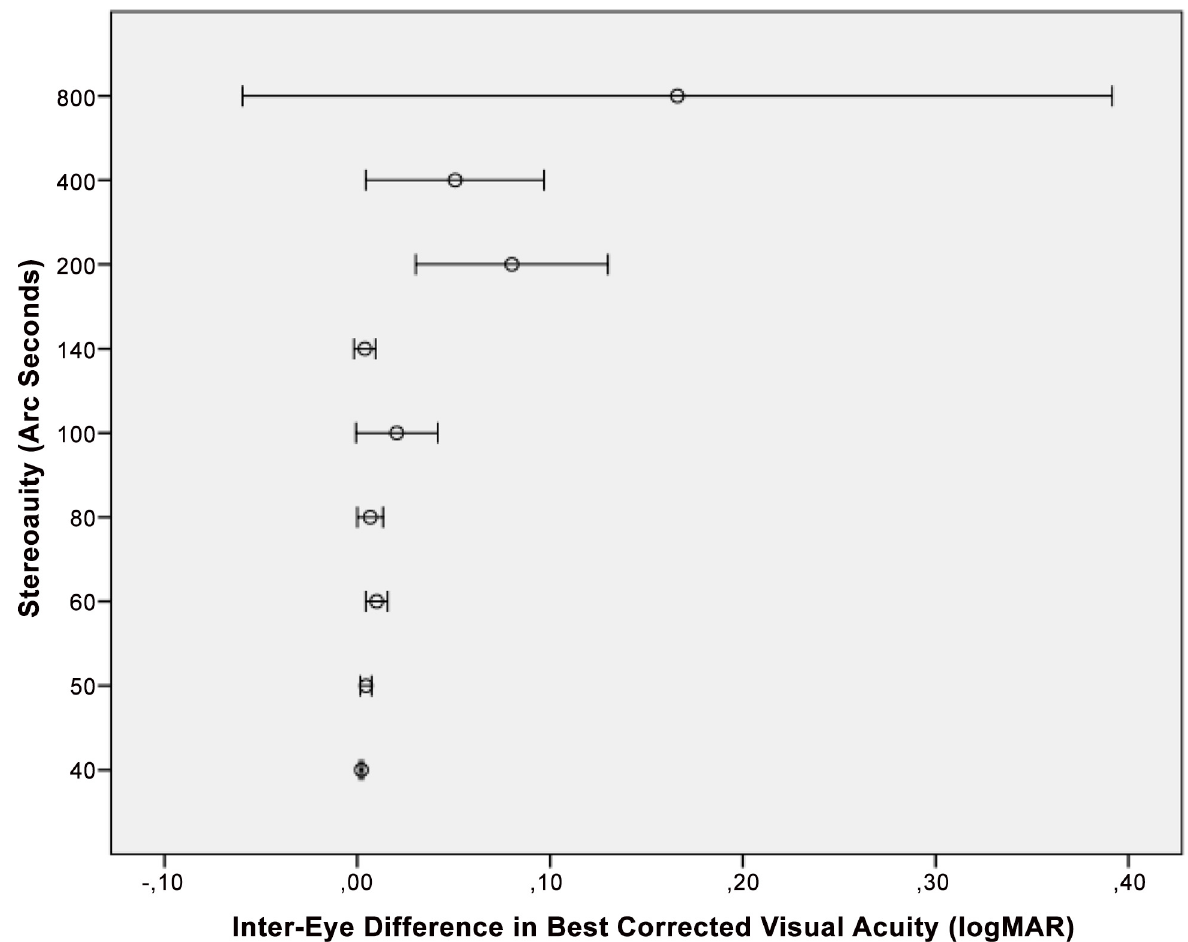
Fig 1. Distribution of Stereoacuity versus the Inter-Eye Difference in Best Corrected Visual